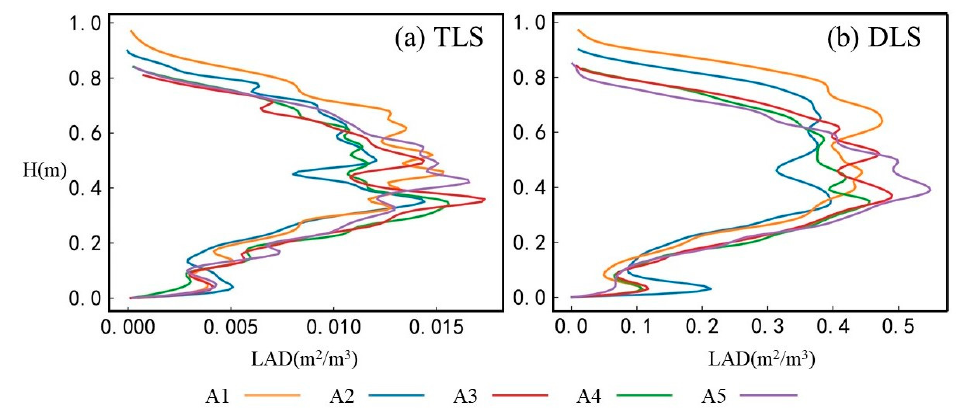
Figure 14. Distribution of LAD curves after curve fi tt ing for di ff erent cultivars at the fi lling period in 2019 for ( a ) TLS data and ( b ) DLS data. 2019 for ( a ) TLS data and ( b ) DLS Table 10. R 2 and RMSE after curve fi tt ing of data on di ff erent platforms in 2019. Platform